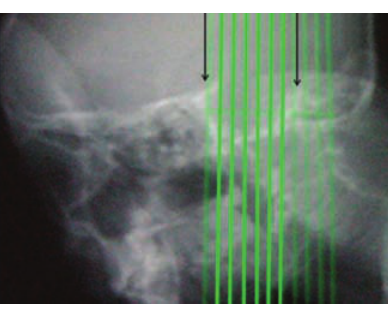
Figure 2. Scanogram for oblique sagittal CT. The scanogram shows study scan lines cover- ing the posterior fossa (arrows show the left and right petrous ridges). Gantry angula- tion=0°. Scans are centered at the level of the petrous ridges. Exposure parameters: 120 kVp,100 mAs, slice thickness 5 mm, spacing 5 mm. Algorithm: standard. In practice, scans are carried out only across the interpetrous region, from one petrous ridge to the other.